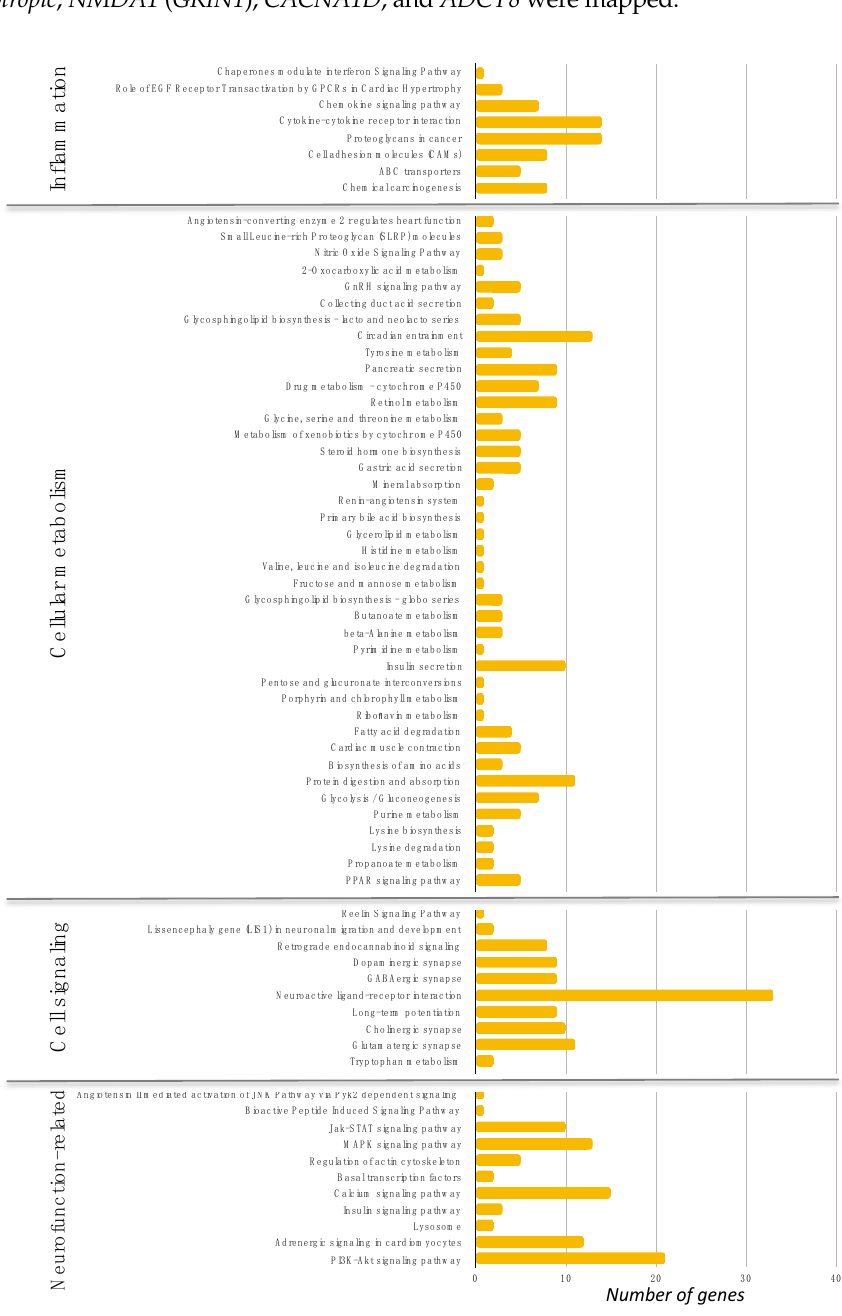
Figure 5. Significantly enriched pathways with differentially expressed genes in volunteers’ PBMC in response to PS pulp consumption. Pathways were identified using Genetrial2 online tool and KEGG database, and were grouped regarding their functions. x -axis represents the number of genes in each pathway.